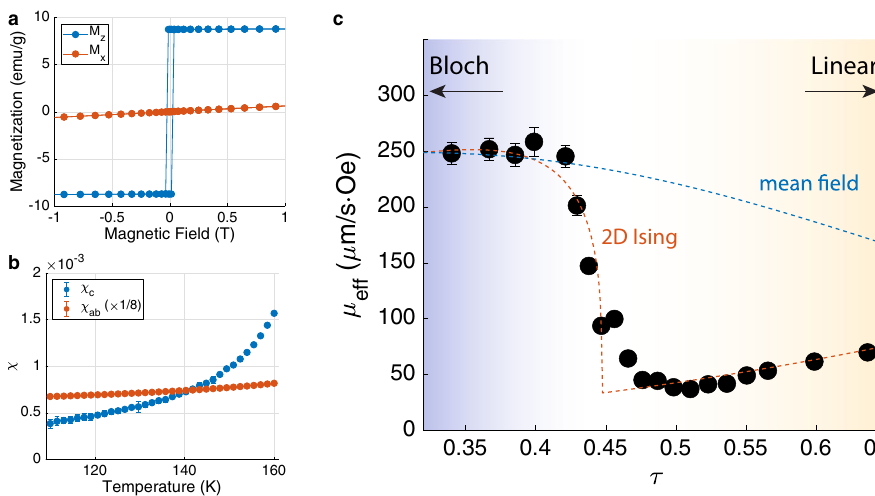
¼ Δ x Δ H , of eff data fi ts is consistent with the DW eff